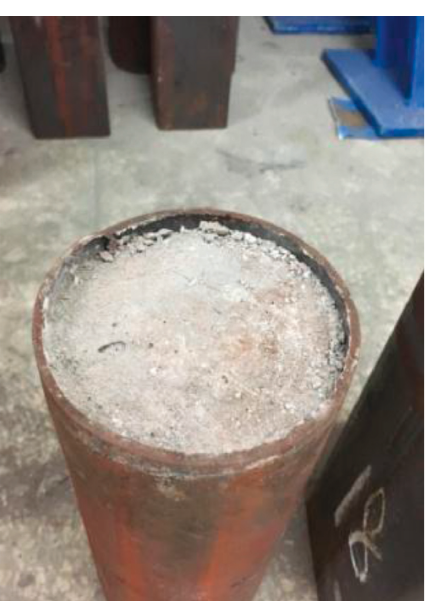
Figure 2: Typical failure mode.